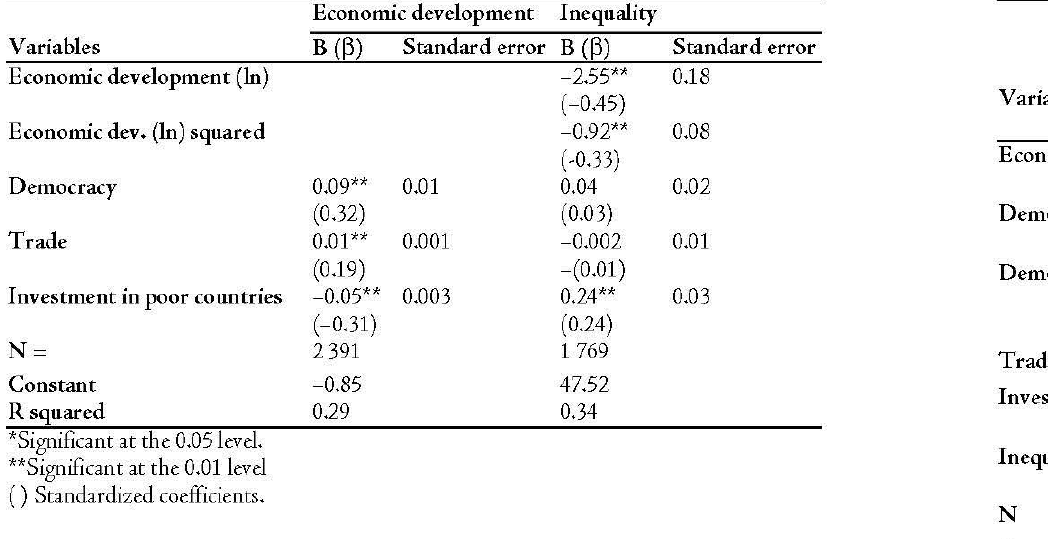
Social Consequences of Globalization, 1965-93, OLS